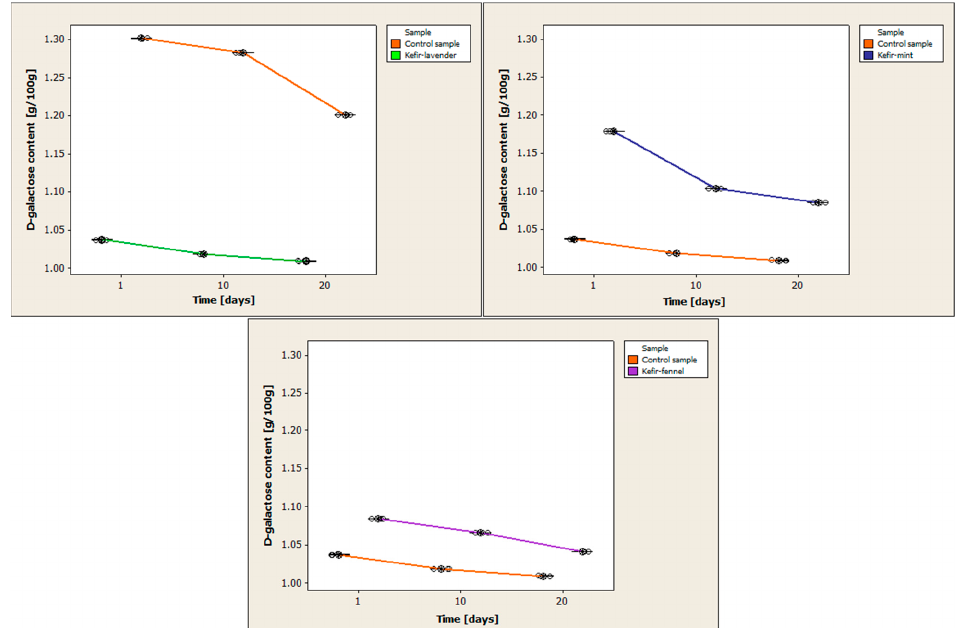
Figure 4. Comparative variation of D-galactose content determined by the enzymatic method in kefir samples with encapsulated volatile oils and the control sample .